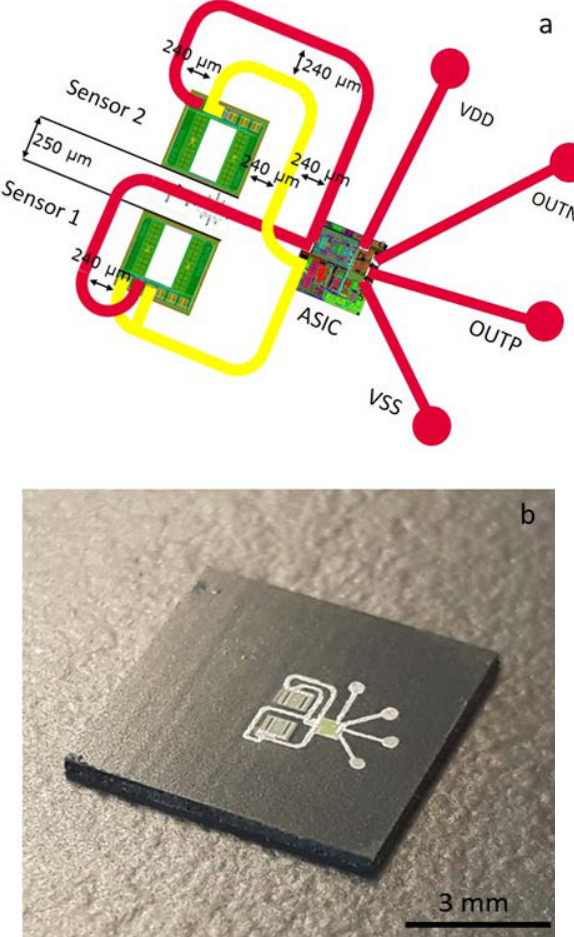
Figure 2. An example for the layout ( a ) and the final demonstrated FOWLP of two capacitive micromachined ultrasonic transducers (CMUTs) and an application-specific integrated circuit (ASIC) chip with inkjet-printed redistribution layers (RDLs) (Comprised of 2 layers of Ag printed lines (red and yellow) and an intermediate insulating printed layer (not shown)) ( b ).